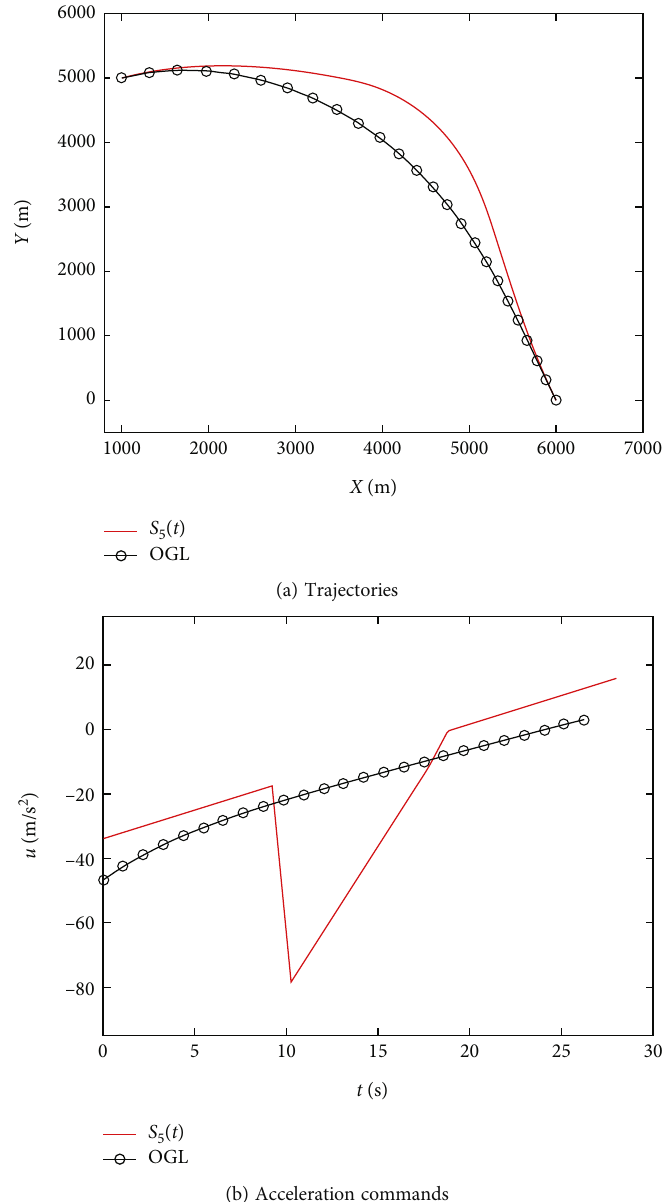
ð 0 Þ = 20 ° , γ = − 70 ° m f